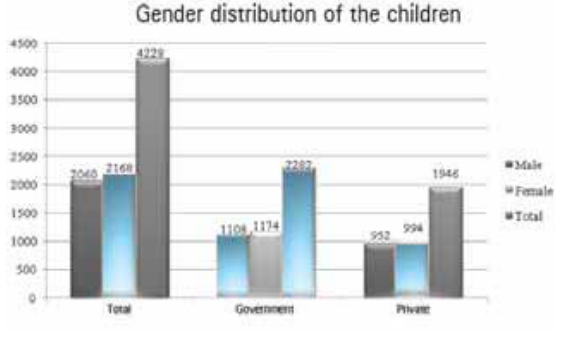
Figure 1. Gender distribution of the children